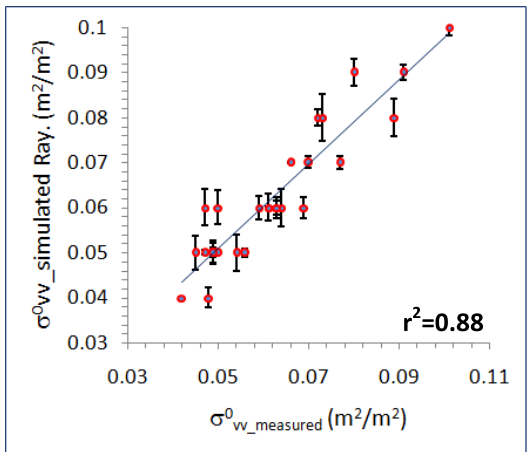
Figure 14. Agreement between measured and simulated values using Rayleigh Model for the σ (Error bars show individual error values). vertical polarization state 0 vv